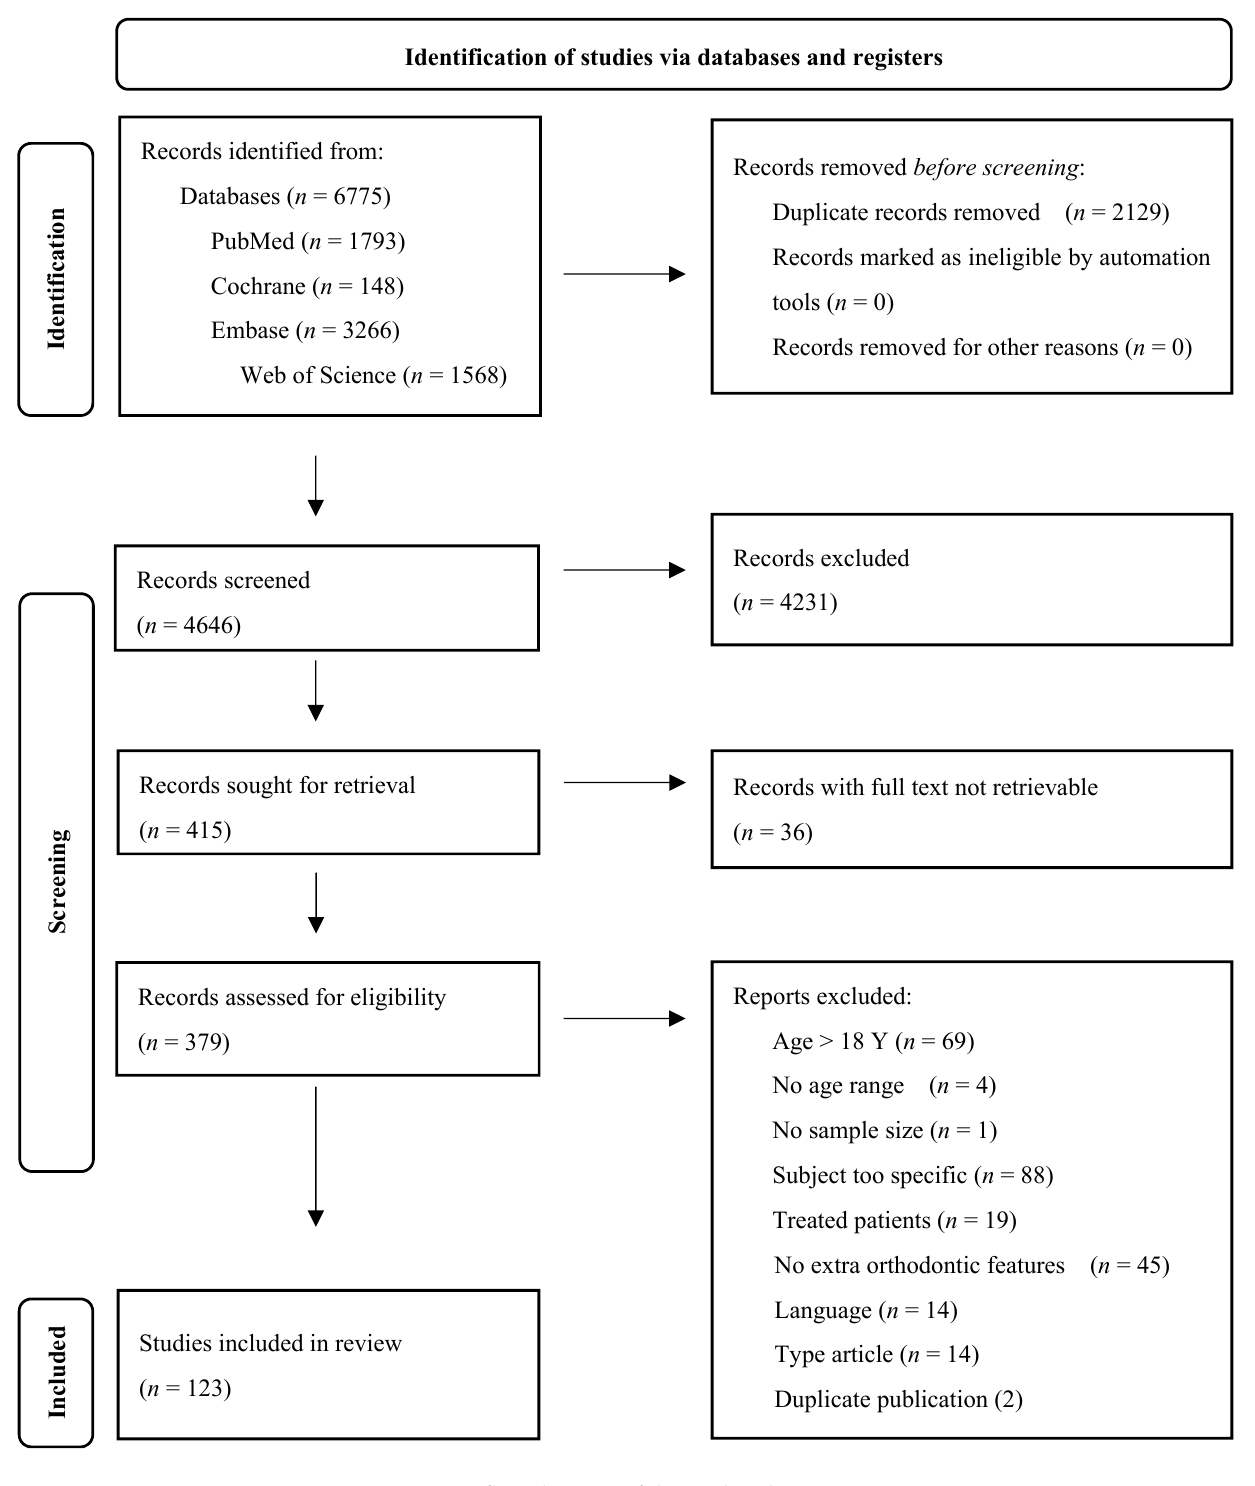
Figure 1. PRISMA flow diagram of the study selection process.